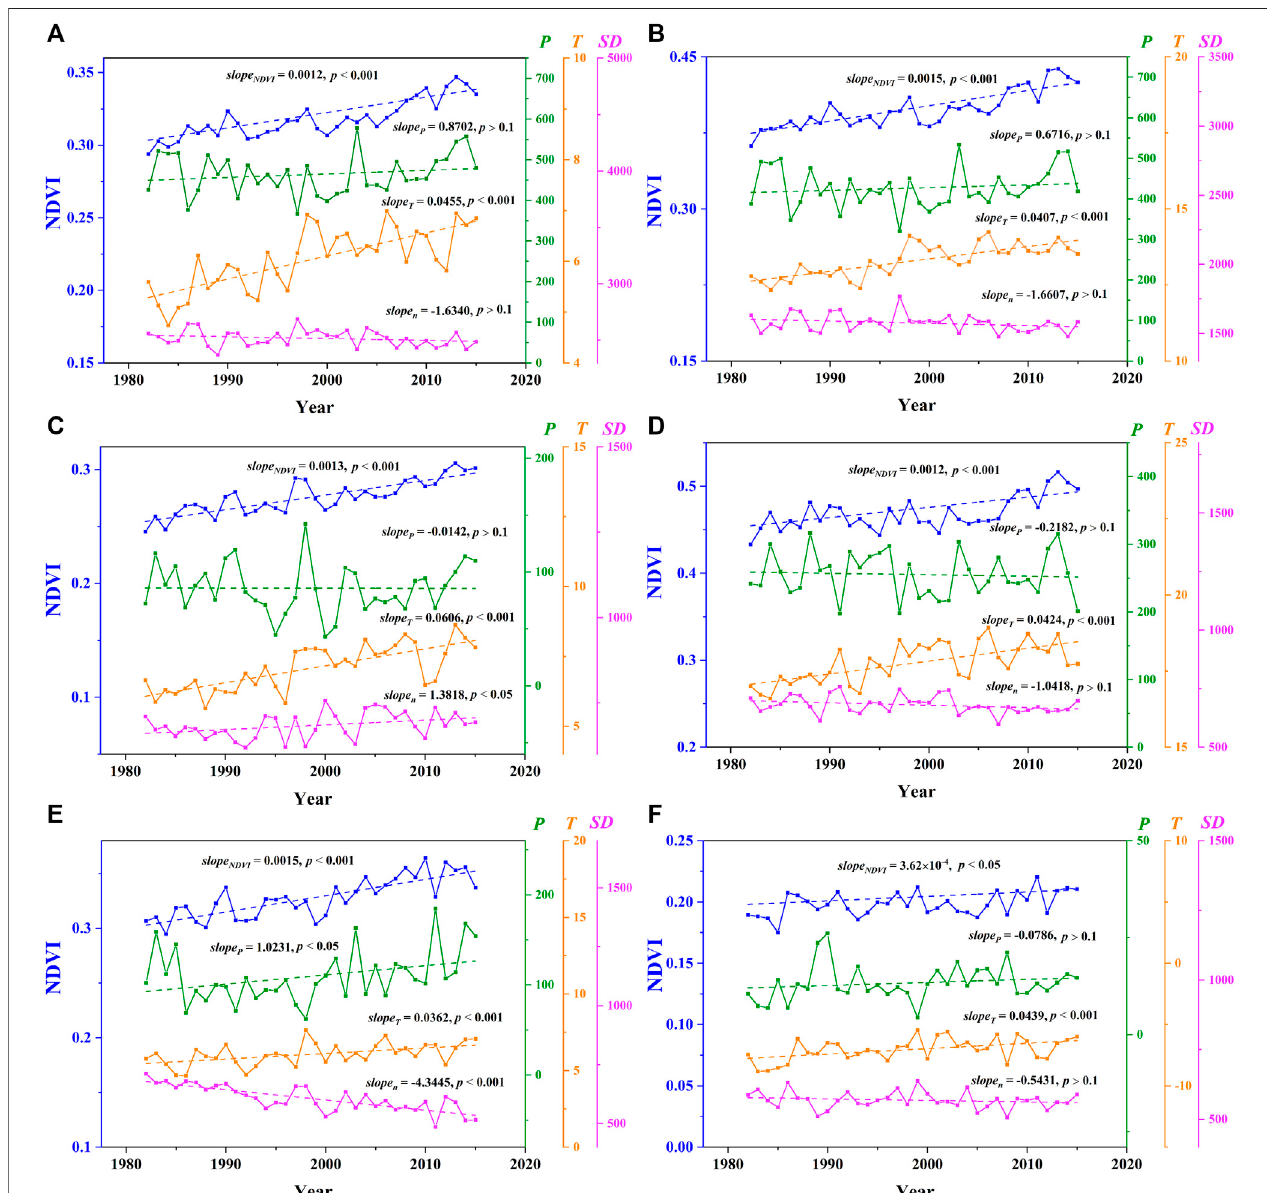
FIGURE4| TrendsofNDVIandprimaryclimatevariablesin (A) annual; (B) growingseason; (C) spring; (D) summer; (E) autumn; (F) winterintheYellowRiverBasin during 1982 – 2015.